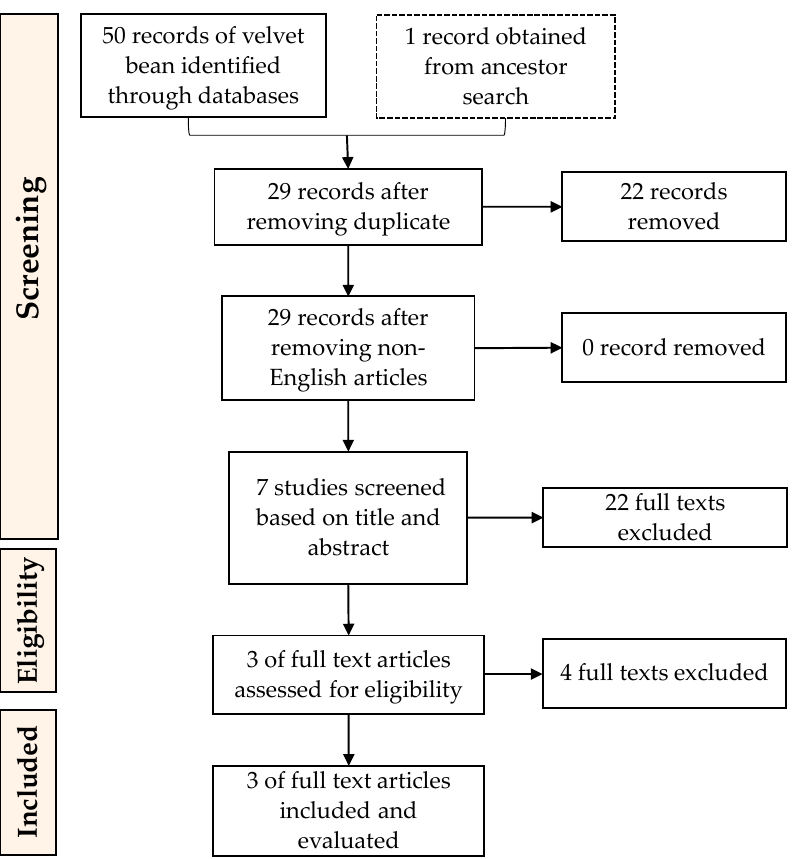
Figure 3. PRISMA guidelines for the inclusion of articles on the enzymatic preparation of ACEi peptides from velvet bean proteins.